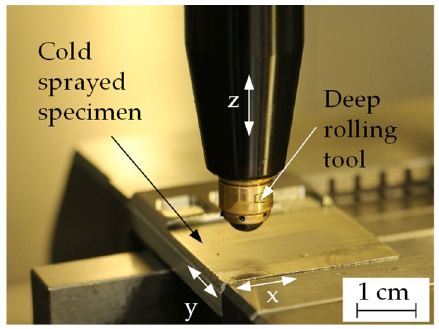
Figure 2. Experimental setup for deep rolling.